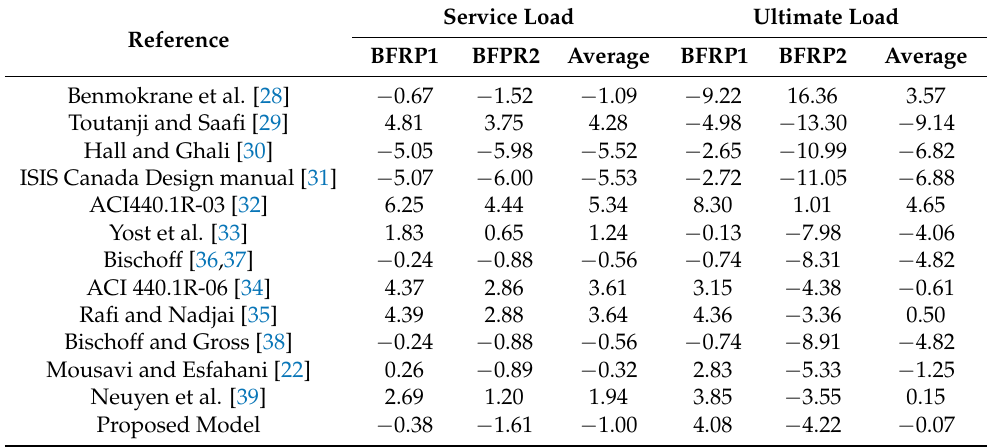
Table 7. Comparison of analytical deflections with experimental values at service load and ultimate load of BFRP